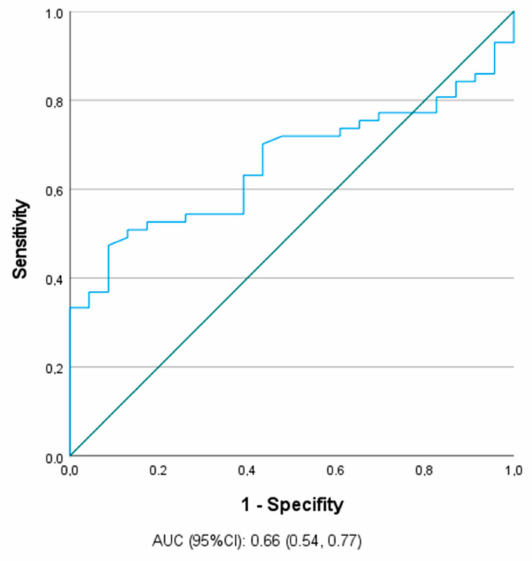
Figure 1. Receiver operating characteristics (ROC) curve of the ability of M65 (cut-off = 125.966 U/mL) to differentiate the adolescents with alcohol